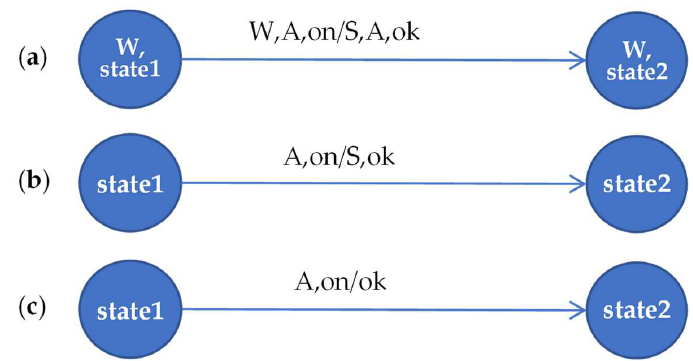
Figure 3. Full description of the action as a transition in the automaton, and its simplifications. W : automaton (server), S : target automaton of a message, A : agent, statei : state values of the server W , on : service of W invoked by the incoming message, ok : service of the server S invoked by the out- going message.